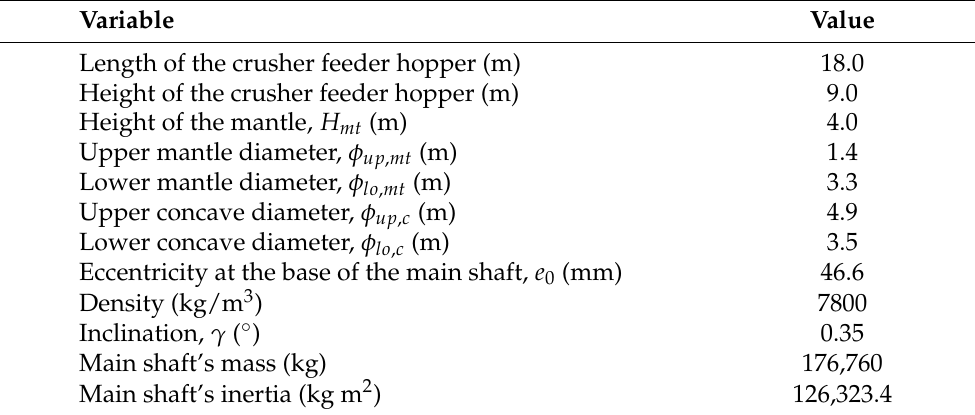
Table 1. Geometrical and material parameters of the geometries of the DEM